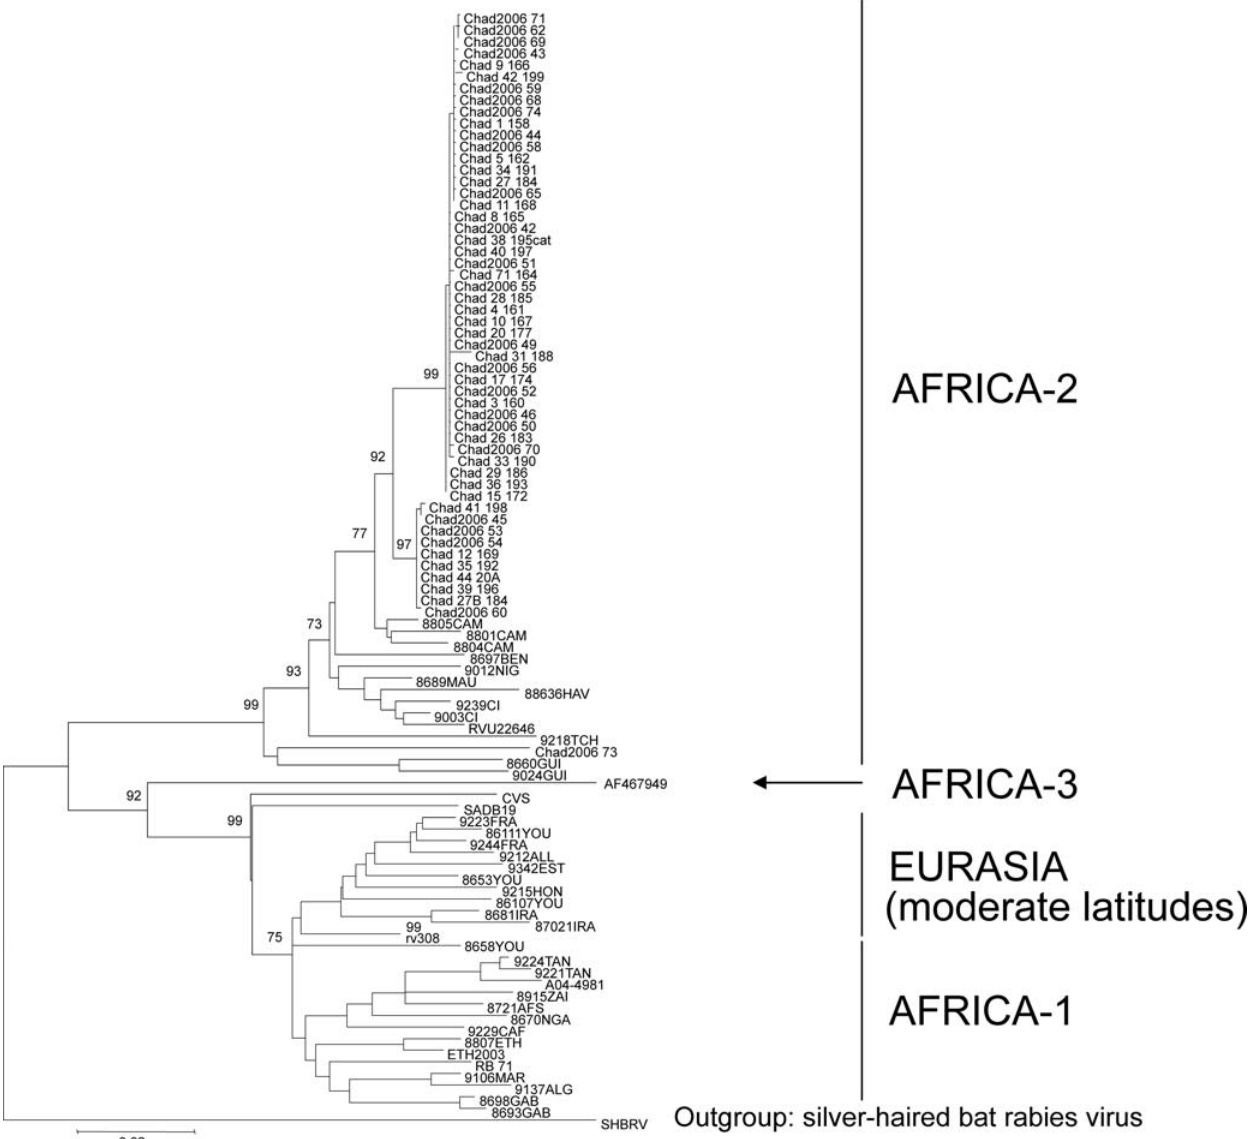
Figure 3. Phylogenetic tree of representative of all African groups (1, 2 and 3) after Kissi et al. (1995) and SHBRV as a root. Branch lengths correspond to differences between sequences (scale at the bottom of the figure). Only significant bootstraps values are shown. The samples of our study are labelled as Chad + number.